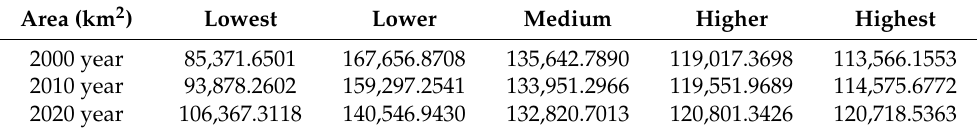
Table 3. The area of each LERI level.